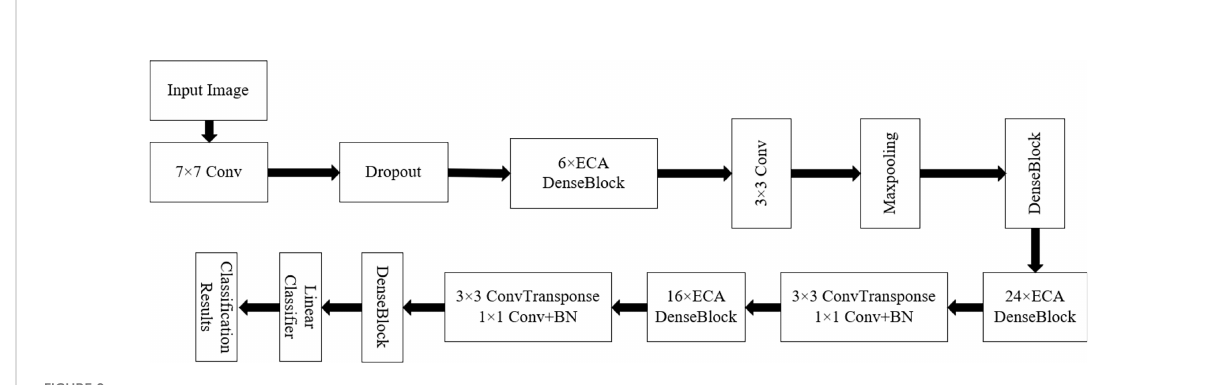
FIGURE 9 Model structure